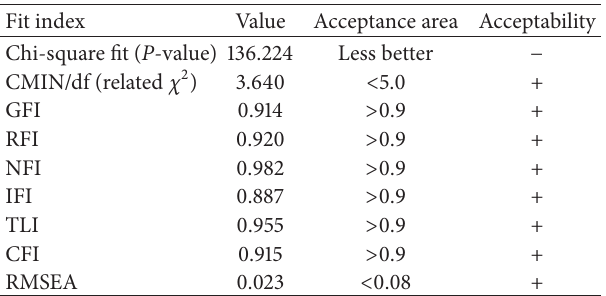
Table 6: Confirmatory factor analysis for final measurement